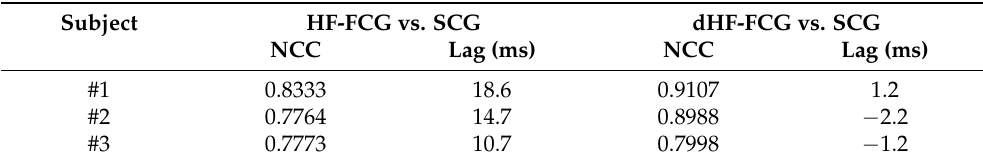
Table 1. Normalized cross-correlation indices (NCC) and time lags between the ensemble averages of HF-FCG vs. SCG and dHF-FCG vs. SCG for each subject. Positive time lags corresponded to FCG signals delayed with respect to SCG.